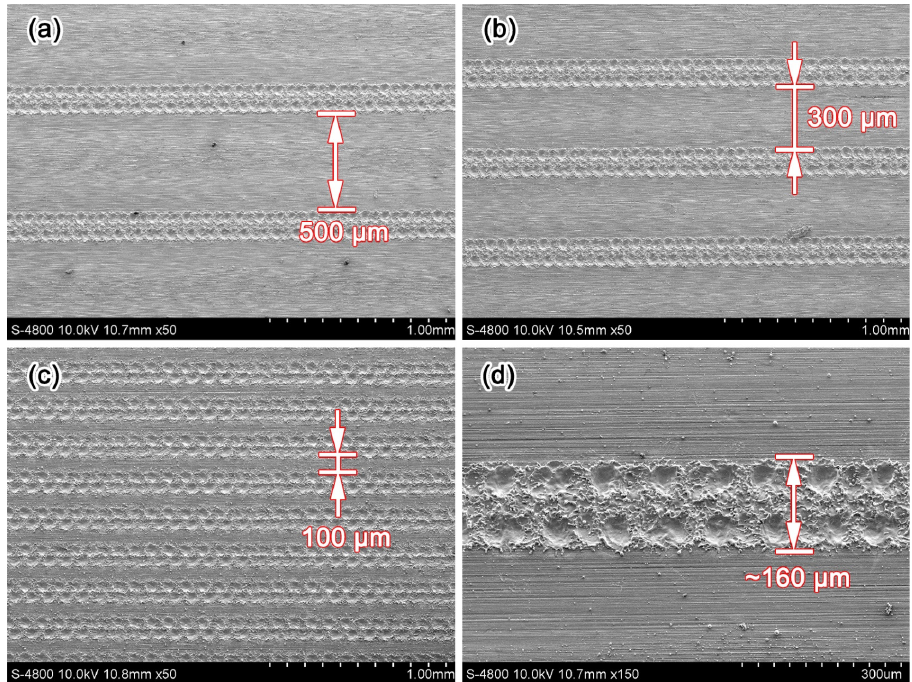
Figure 2. SEM images of the textured surfaces for dimple densities of ( a ) 25.3%, ( b ) 36.2%, ( c ) 63.0%, and ( d ) partially enlarged dimples of